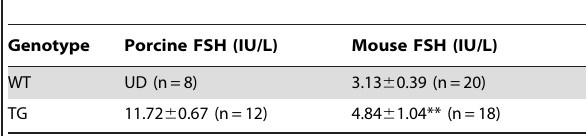
Table 3. Serum levels of FSH in TG and WT female